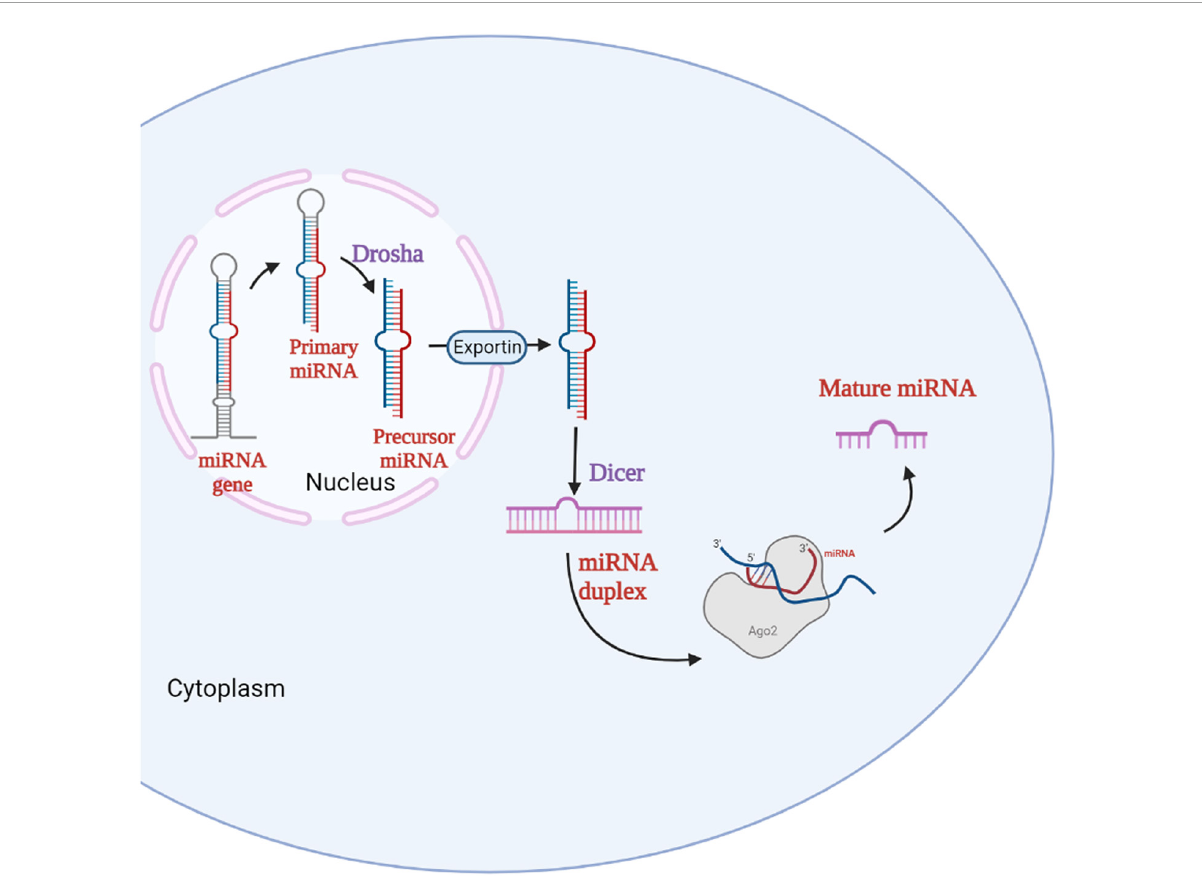
FIGURE1 Biogenesis of miRNA. The miRNA gene in the nucleus is transcribed to primary miRNA which is then converted to precursor miRNA by the enzyme Drosha. The precursor miRNA enters the cytoplasm via Exportin and forms the miRNA duplex with the help of Dicer. The miRNA duplex forms the mature miRNA with the help of RNA-Induced Silencing Complex